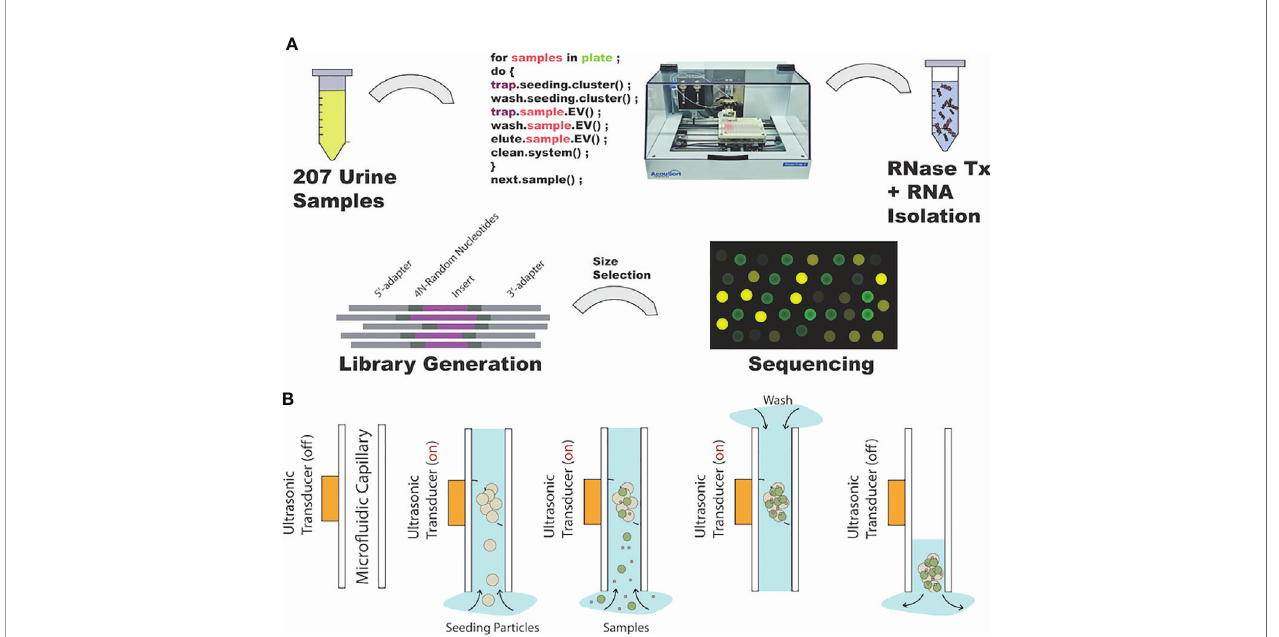
FIGURE 1 | Urinary extracellular vesicle (EV) isolation and processing work fl ow. (A) Schematic of work fl ow beginning with urine sample randomization, automated EV isolation by AcouTrap, RNA isolation, small RNA library preparation and fi nally sequencing. (B) Illustration of acoustic trapping steps. From left to right, ultrasonic transducer coupled to micro fl uidic channel where sample fl ows. Seed particles (12 m m) that will serve as anchors for vesicles are trapped. Next, samples containing vesicles are aspirated through the seed cluster where EV enrichment occurs. After sample aspiration, seed cluster with enriched EVs is washed with PBS and lastly dispensed into designated